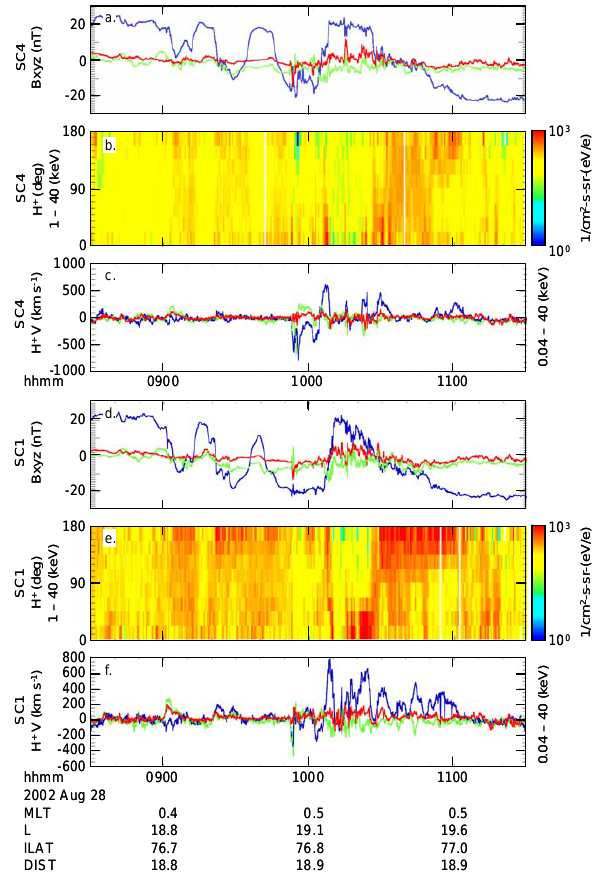
Fig. 4. (a) GSE magnetic field components x (blue), y (green), and z (red), measured by SC 4 near the apogee. (b) Corresponding proton flux pitch-angle distribution, averaged over 1 − 40 keV. (c) GSE proton bulk flow components x (blue), y (green), and z (red), as inferred at SC 4. (d) − (f) Same displays for SC 1. Ephemeris at bottom is that of SC 1 (cf. Table 1).